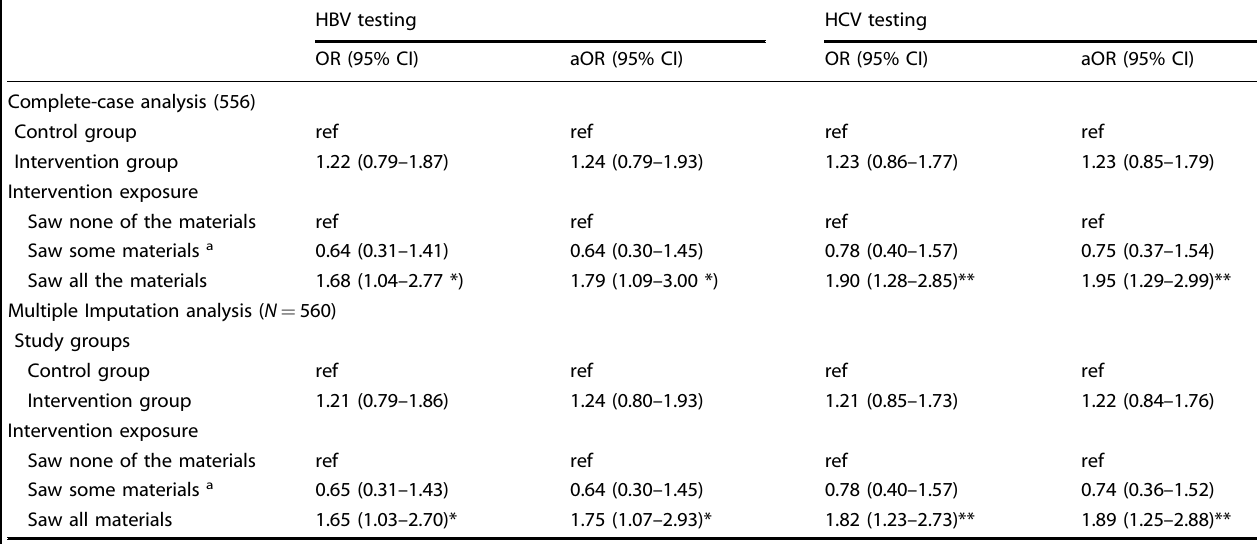
Table 3. Per-protocol analysis evaluating the impact of a crowdsourced intervention on hepatitis testing uptake among 560 primary care users in urban China, 2019 –